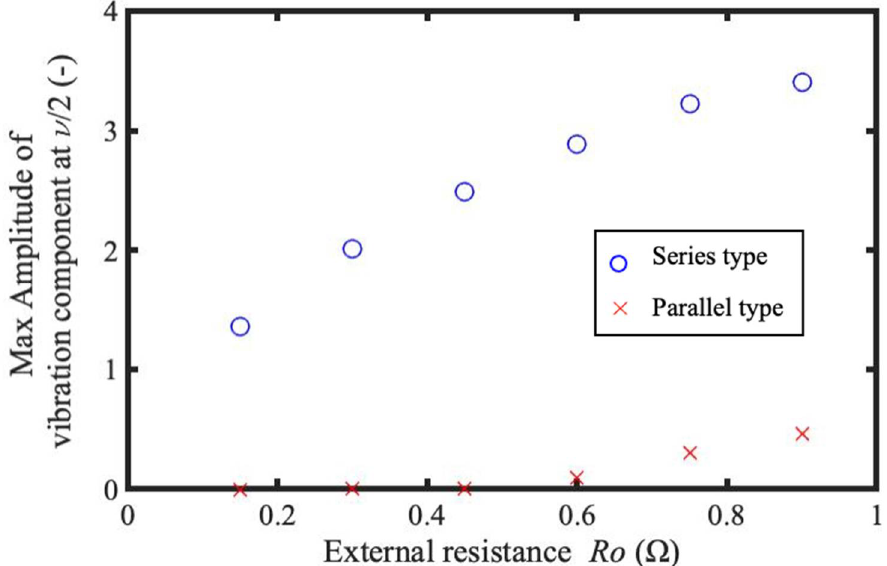
Figure 9. Numerical result of the relationship between maximum amplitude of the vibration com- ponent at half the excitation frequency and external resistance value R o obtained with each of the series-type and parallel-type dampers.